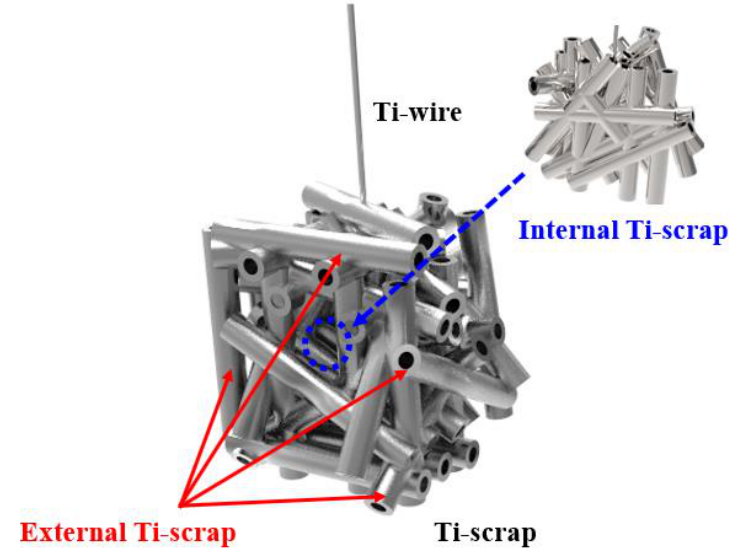
Figure 4. Method of separation for deoxidated Ti scrap analysis.